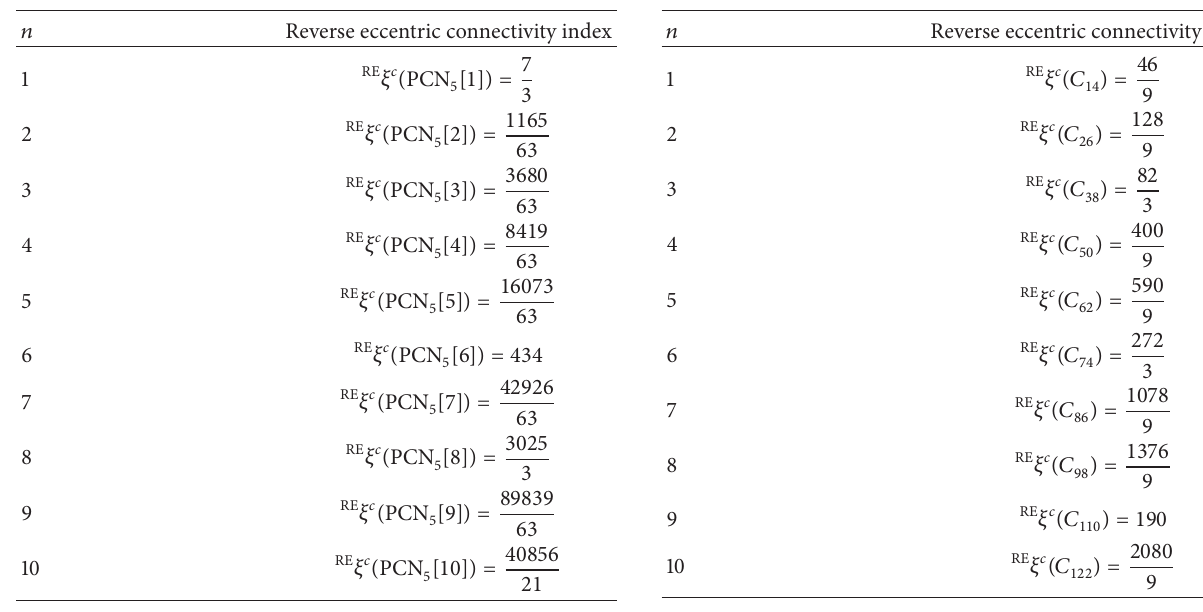
Table 1: Some exceptional cases of reverse eccentric connectivity index of PCN 5 [𝑛] .